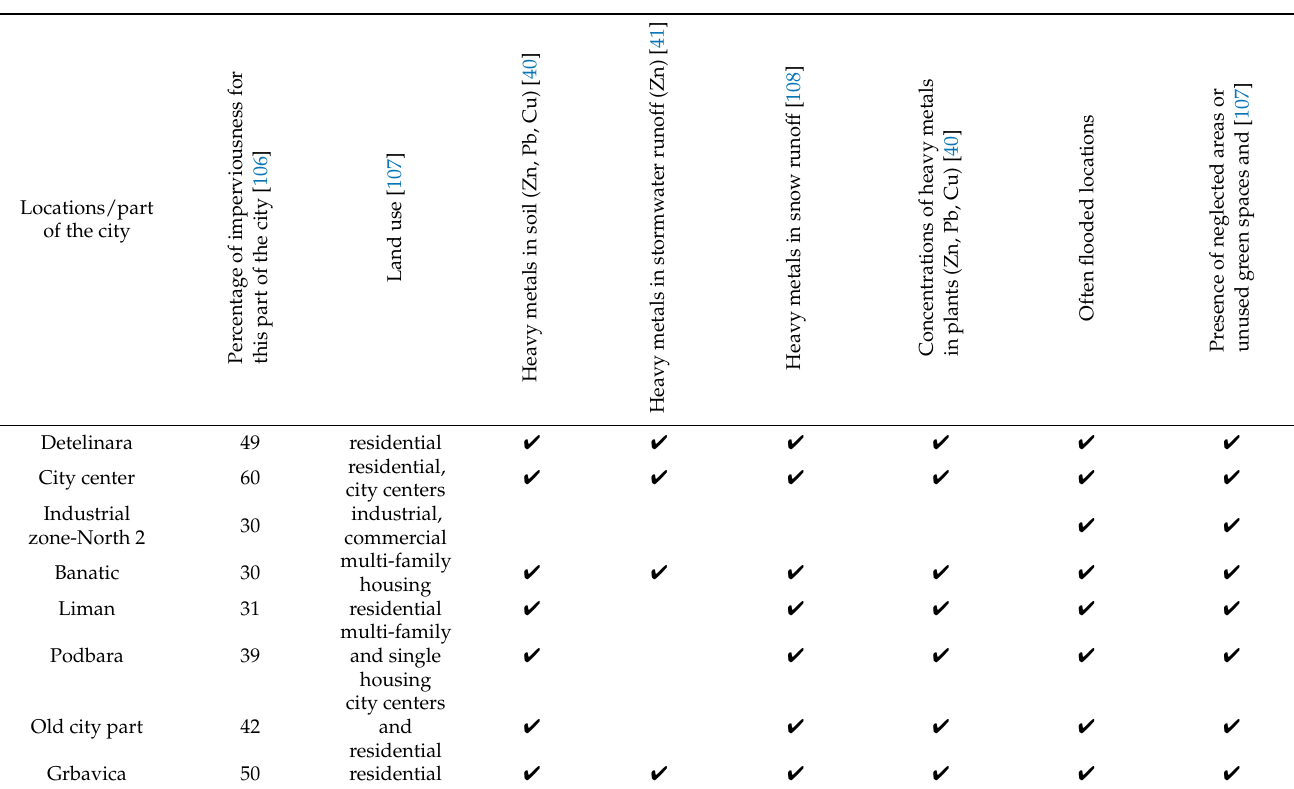
Table 5. Potentials on implementing NBS in urban context of Novi Sad based on important indicators such as detected environmental